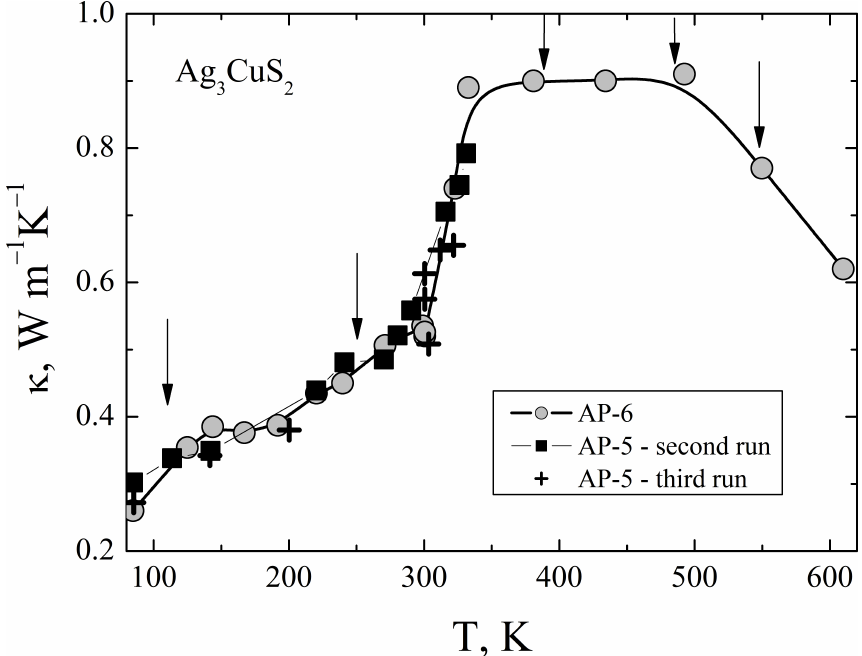
Figure 3. Thermal conductivity of Ag 3 CuS 2 . The arrows indicate temperatures of the structural phase transitions according to Ref.